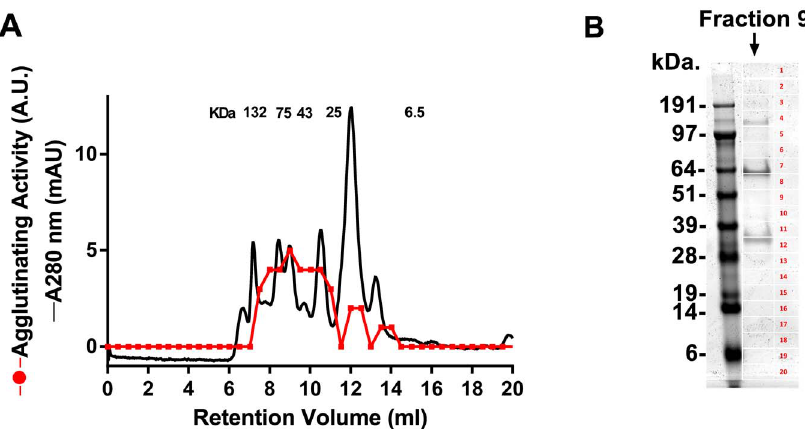
Figure 4. An.gambiae SGH purification and MS analysis. (A) One hundred pairs of SGH were loaded in a gel-filtration column, and eluted in PBS containing 0.1% PEG 4000. The fractions were tested for lectin activity. (B) MS analysis. The fraction (retention volume at 9 ml) containing the highest activity was used for 1D PAGE. Twenty gel bands were cut, followed by in-gel tryptic digestion, and nano-LC MS/MS (results presented in Table S1).